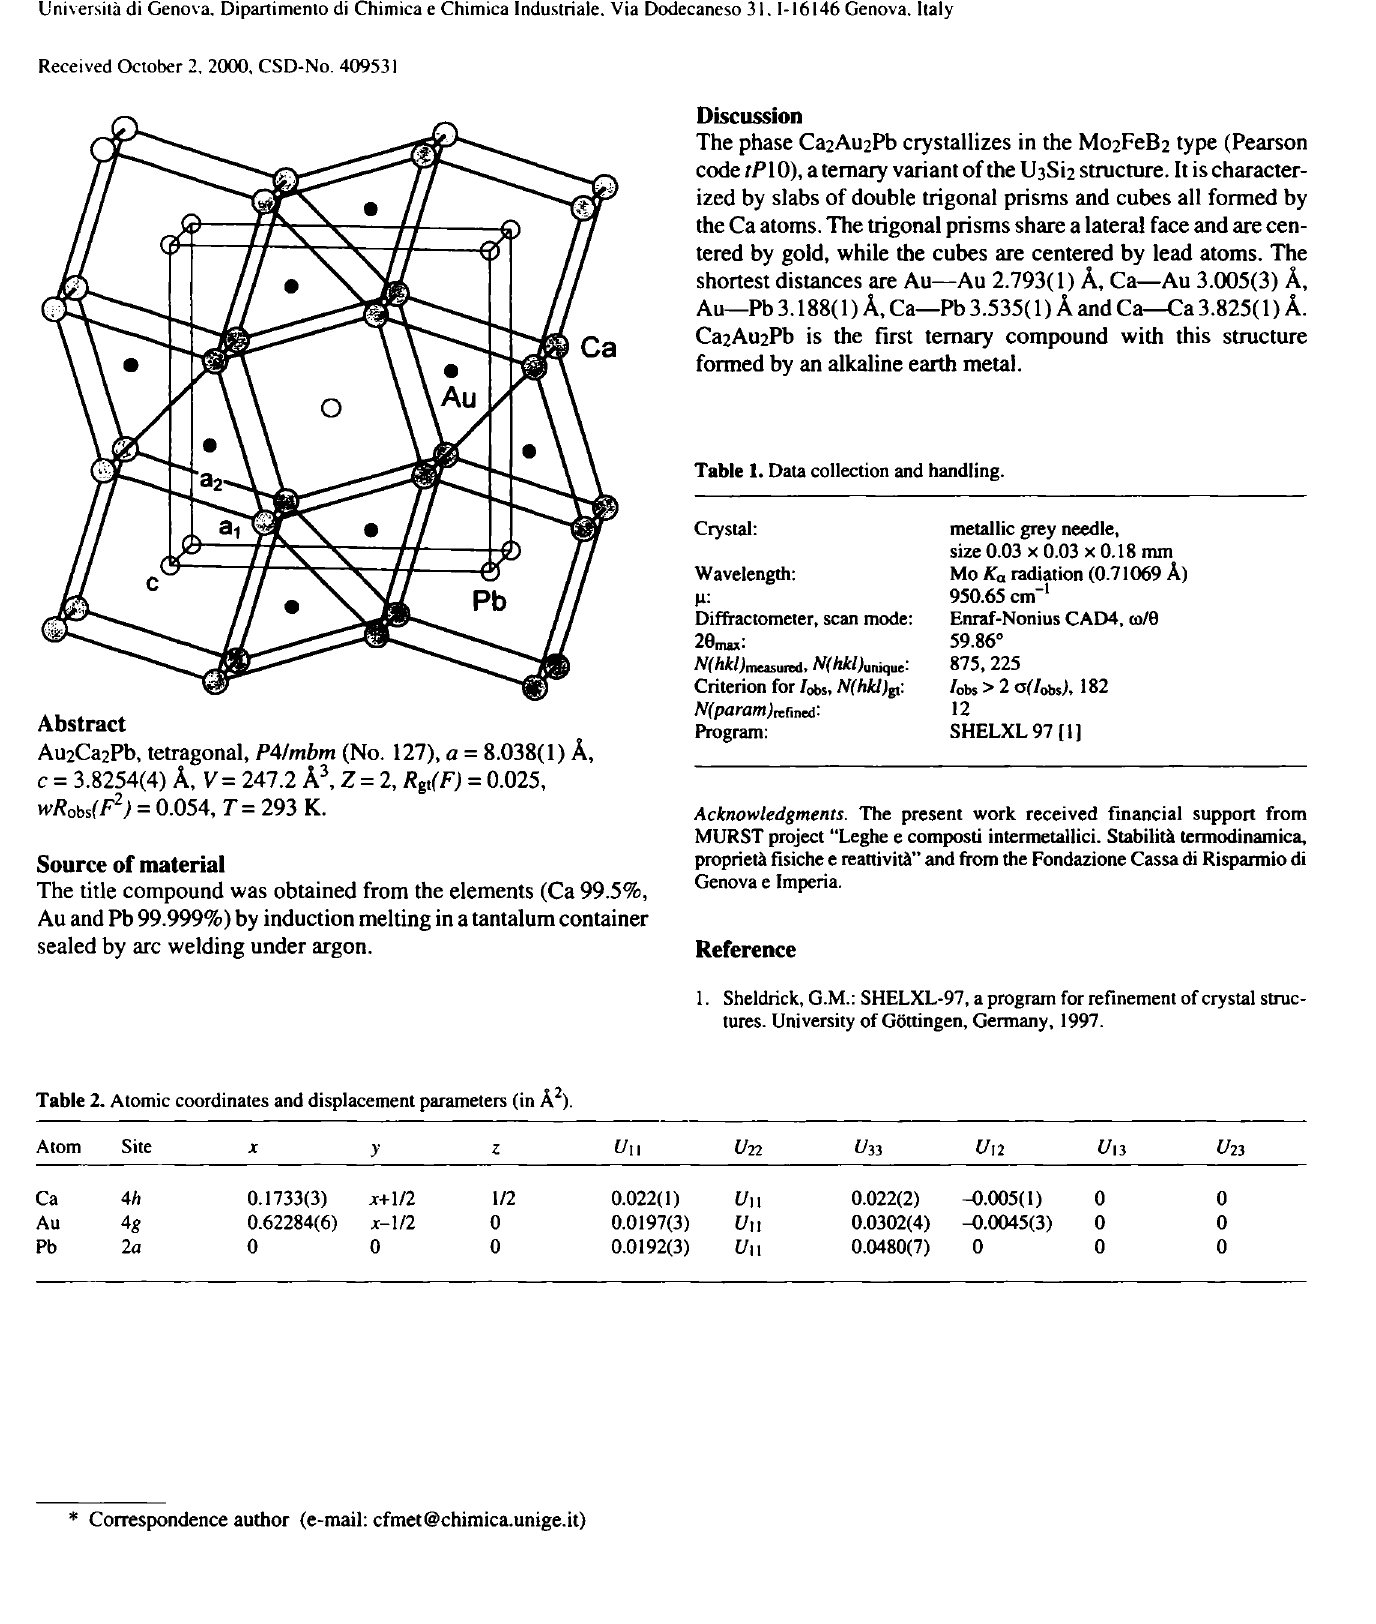
Discussion The phase Ca2Au2Pb crystallizes in the Mo2FeB2 type (Pearson code /P10), a ternary variant of the U3S12 structure. It is character- ized by slabs of double trigonal prisms and cubes all formed by the Ca atoms. The trigonal prisms share a lateral face and are cen- tered by gold, while the cubes are centered by lead atoms. The